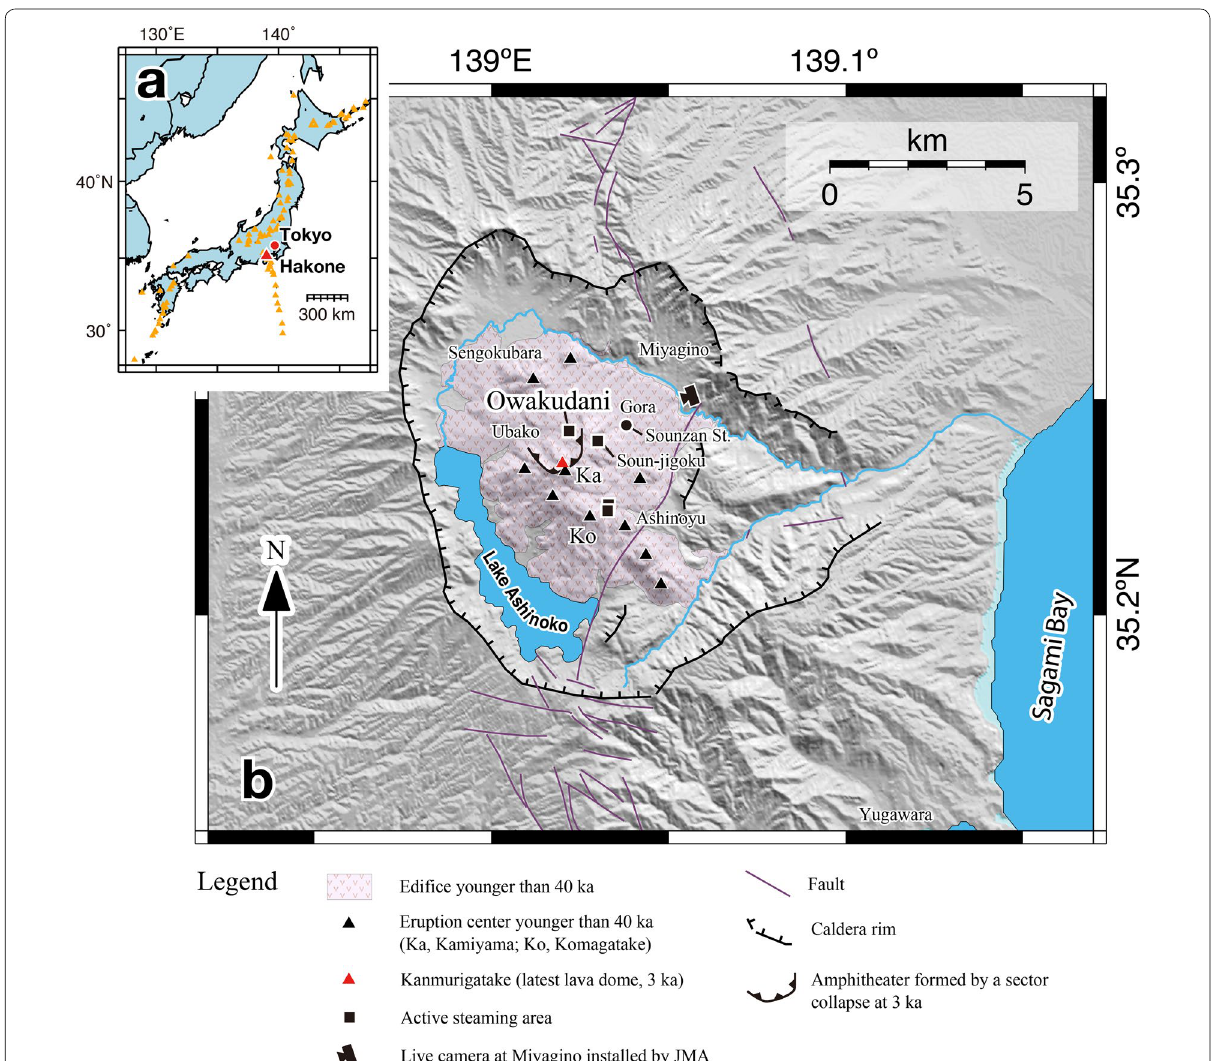
Fig. 1 Index map of Hakone volcano and Owakudani, center of the 2015 eruption. a Location of Hakone volcano. Yellow triangle indicates active volcano. b Topographical map of Hakone